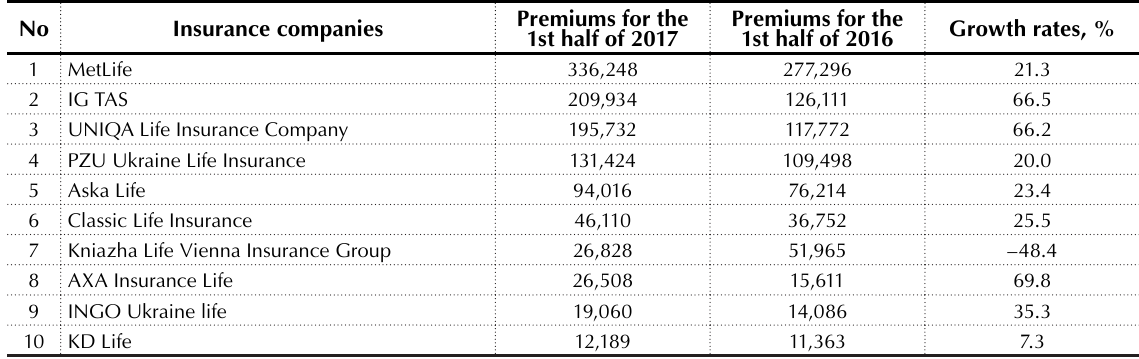
Table 3. TOP-10 largest life insurance companies by premiums for the first half of 2017 (ths. UAH)